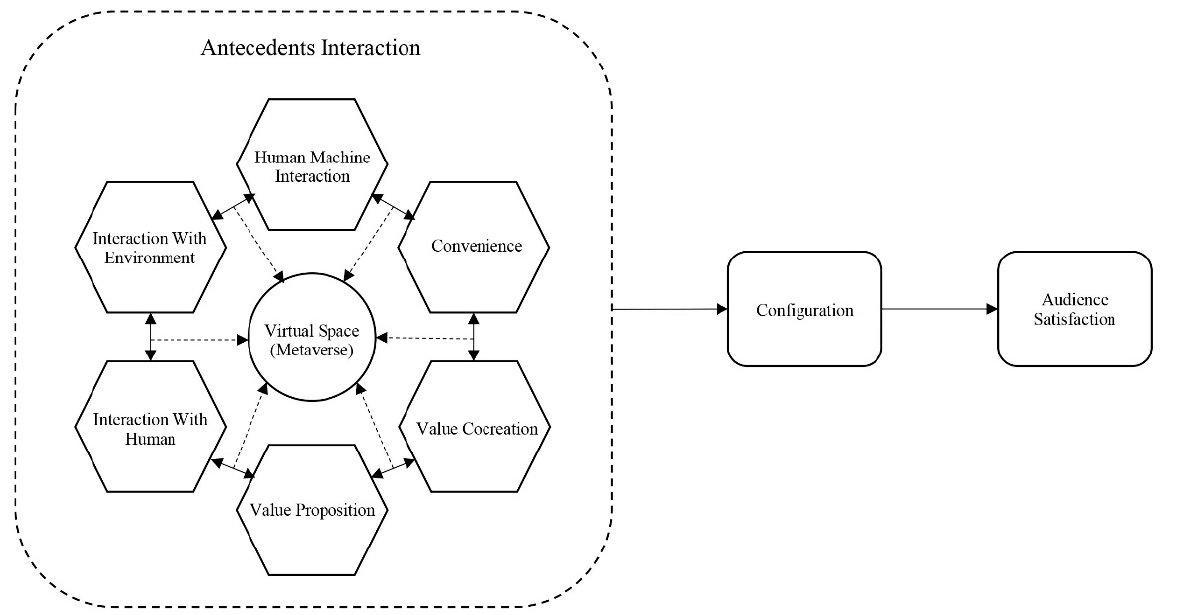
Figure 2. Configuration framework of influencing factors on audience satisfaction with virtual space (metaverse).